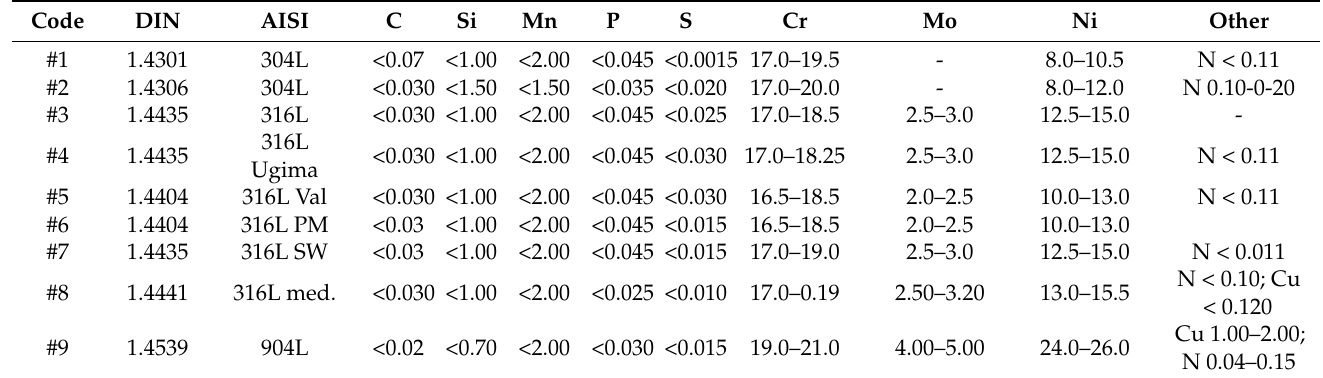
Table 1. The nominal chemical composition (%) of austenitic steels used in watch